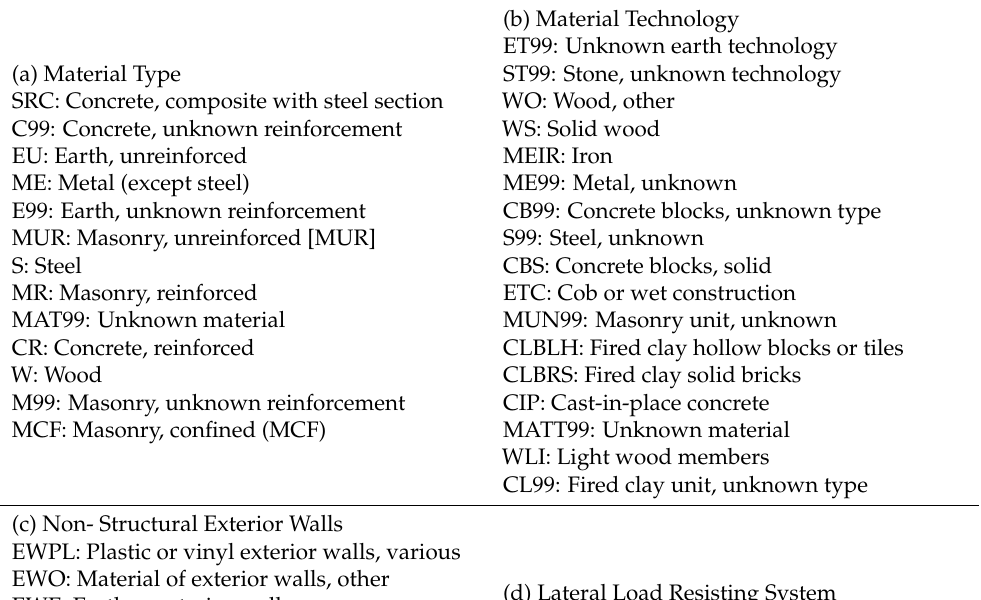
Table A3. Observed attribute values incorporated into the four attribute types in Figure A5.